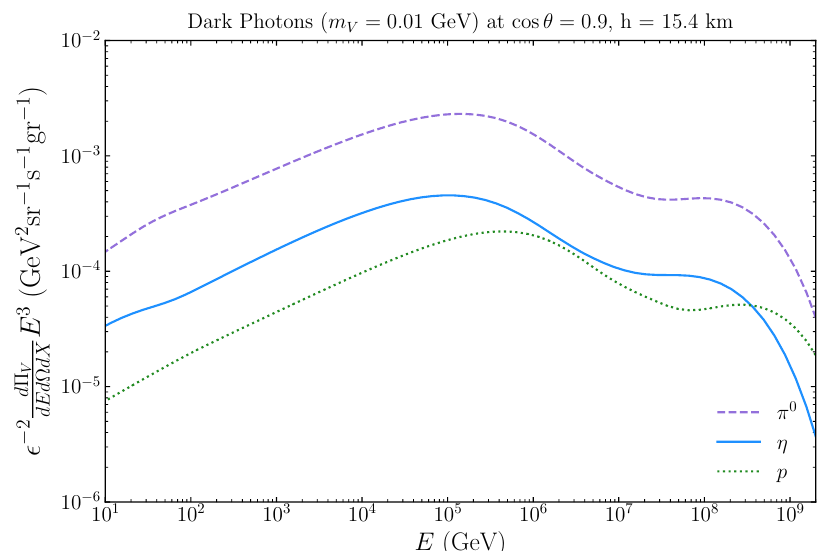
Figure 8 . Production pro(cid:12)le of dark photons produced from (cid:25) 0 ; (cid:17) decay and proton bremsstrahlung, for m V = 10 (cid:0) 2 GeV. The pro(cid:12)le is shown at approximately 15 km from the